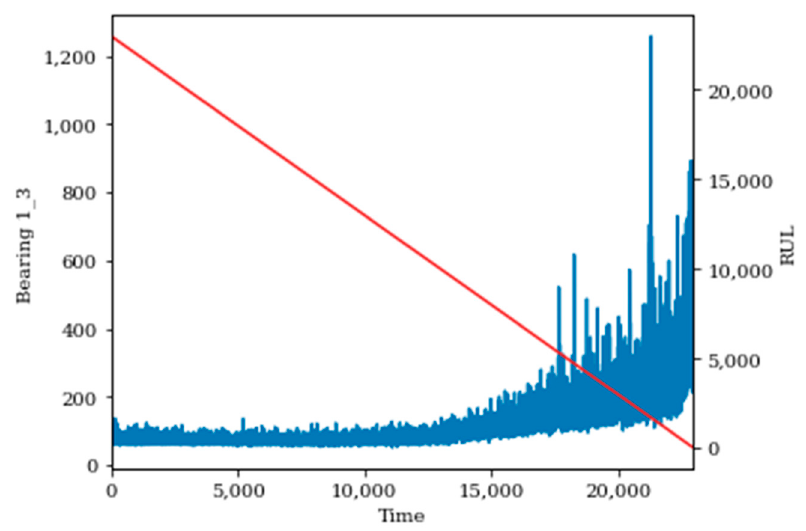
Figure 15. Processed Spectrogram (STFT) Degradation Data for Bearing 1–3.